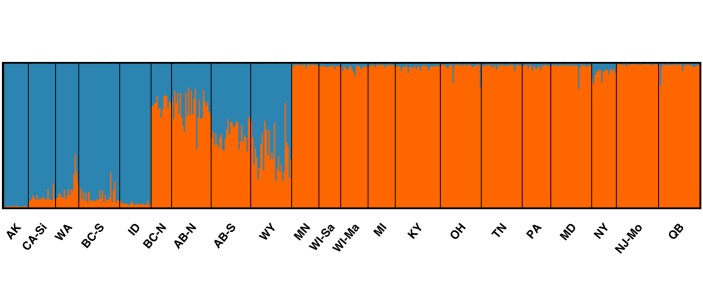
Proportional membership (Q) of M. lucifugus to genetic clusters for K = 2 estimated using STRUCTURE with sampling location as prior information.Each bar is a single individual, sampled populations are delineated by black lines and are ordered by geographical sampling location from west to east. Colors distinguish genetic clusters (blue for proportional membership in the western cluster, orange for proportional membership in the eastern cluster).